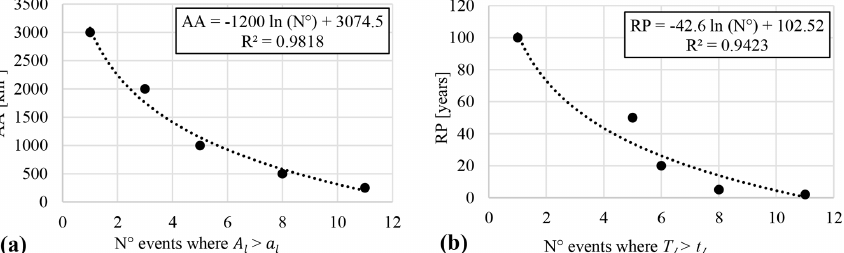
Figure 7. Frequency–magnitude relationship for (a) affected area (AA) parameter and (b) return period (RP) parameter. N o is the number of events analysed in the study.